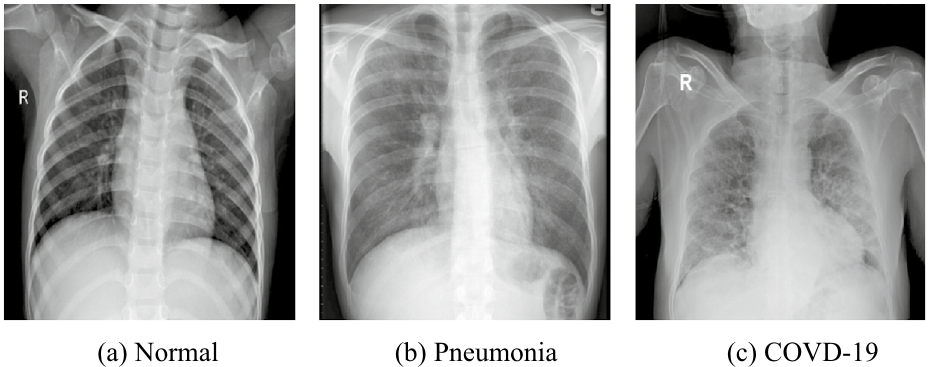
Figure 1. CXR for healthy and ill people from COVIDx datasets 9 , which classifies CXRs into classes of: ( a ) Normal case, ( b ) Pneumonia case, and ( c ) COVID-19